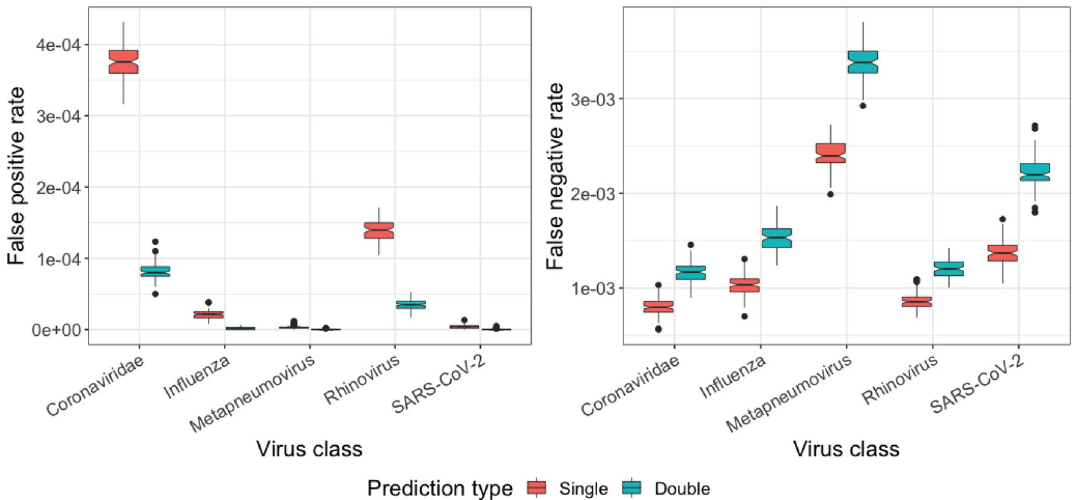
Figure 2. Comparison of false positive and false negative rates between single and double predictions . Single prediction (red) results in relatively higher false positives and lower false negatives compared to double prediction (green) where predictions are made on both the positive strand of a sequence read and its reverse complement.